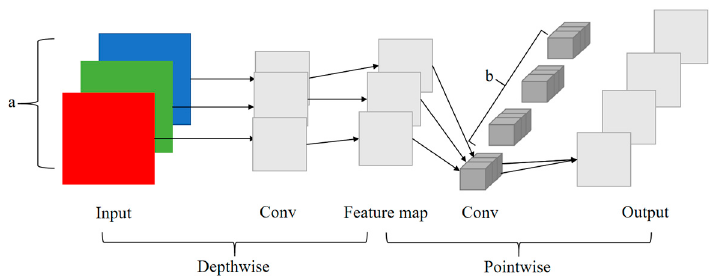
Figure 3. Depthwise separable convolution.